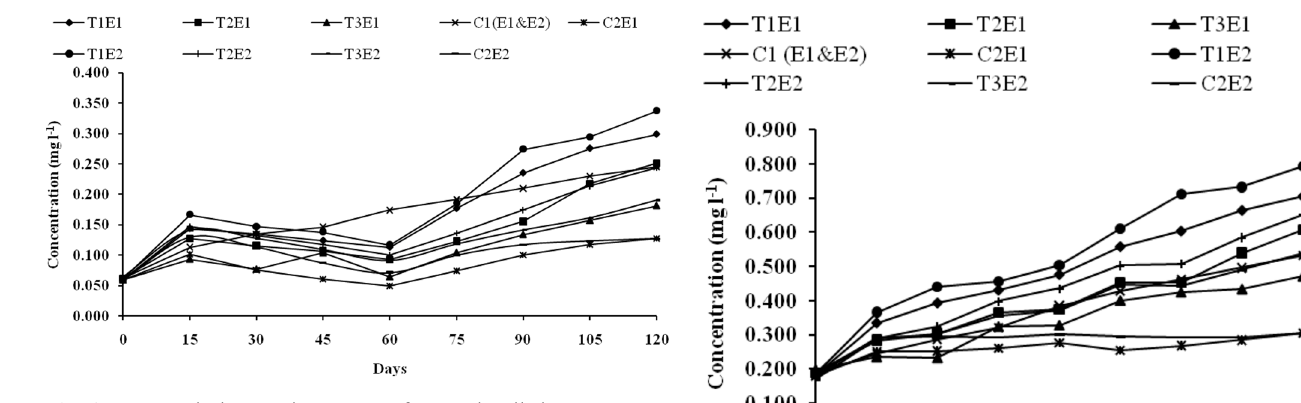
Fig. 2. Temporal changes in NH 3 -N of water in all the treatments of E1 and E2.